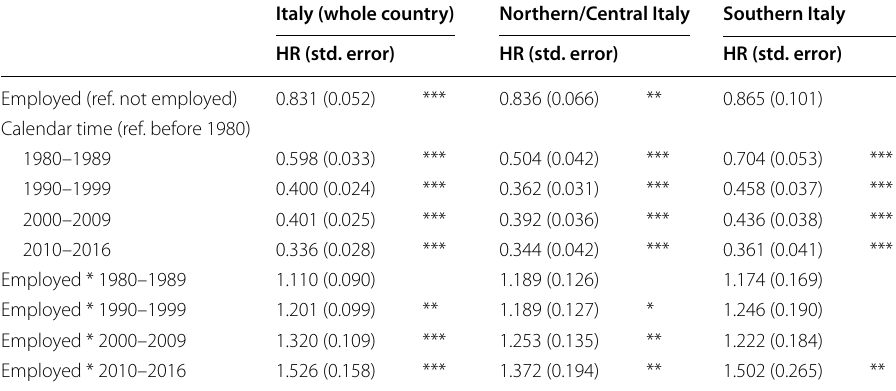
Table 5 Employment status and transition to motherhood over time, only women who have never worked for more than 6 months in the macro-area opposite to that they live in at the time of the interview. Cox models, HRs are reported with standard errors in